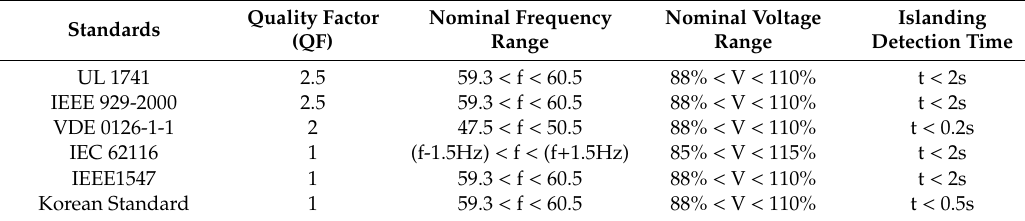
Table 1. Optimal operation standard for the microgrid in islanded mode